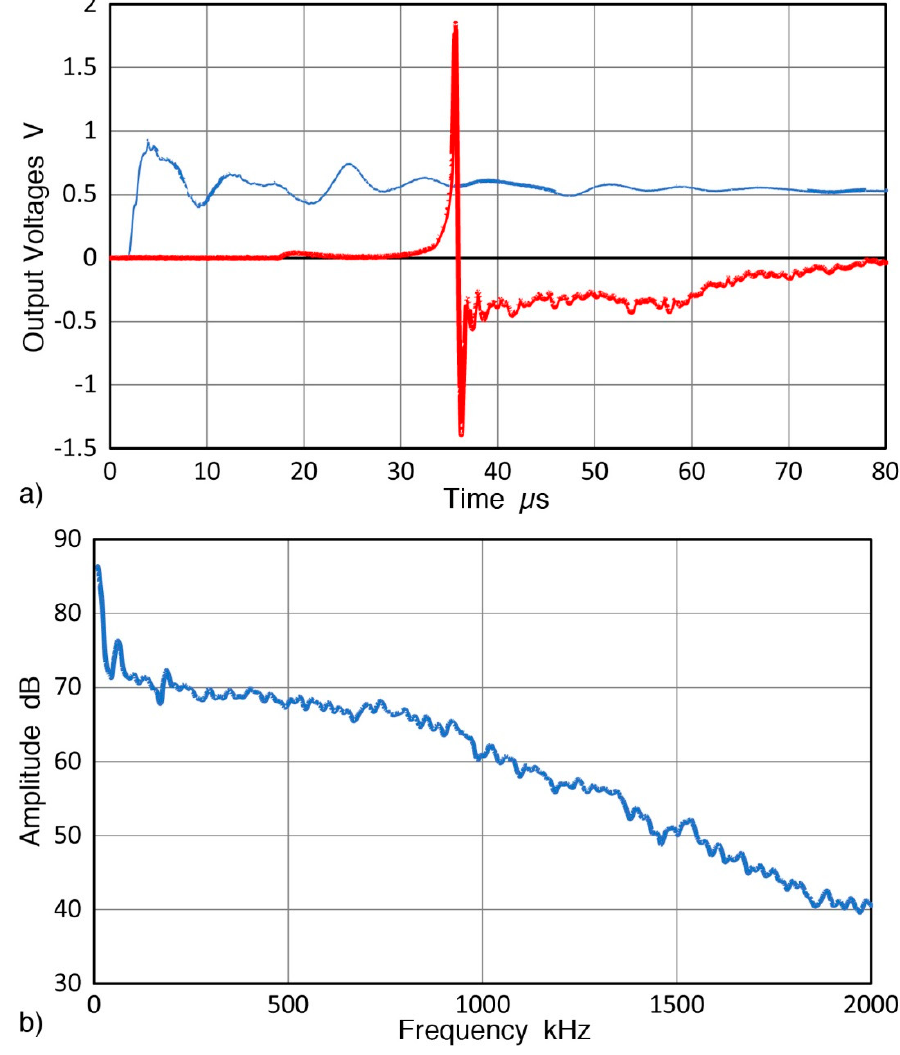
Figure 8. ( a ) Output voltages of reference sensor (KRNBB-PC) from GC fracture in red and force transducer (V112) in blue. Both were normalized to 10 N fracture force. ( b ) Averaged spectrum of eight received signals, also normalized to 10 N fracture force.